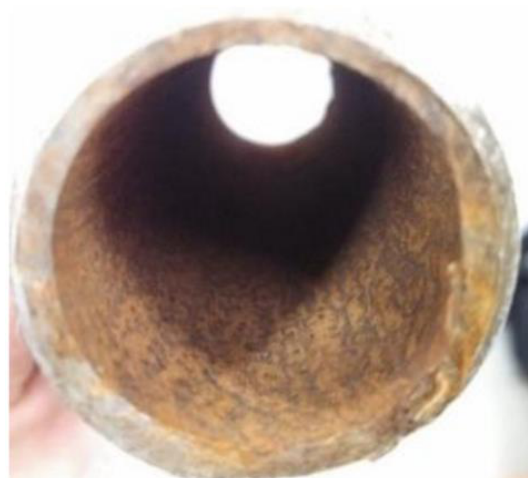
Fig. 13 Coarse-textured surface [5]